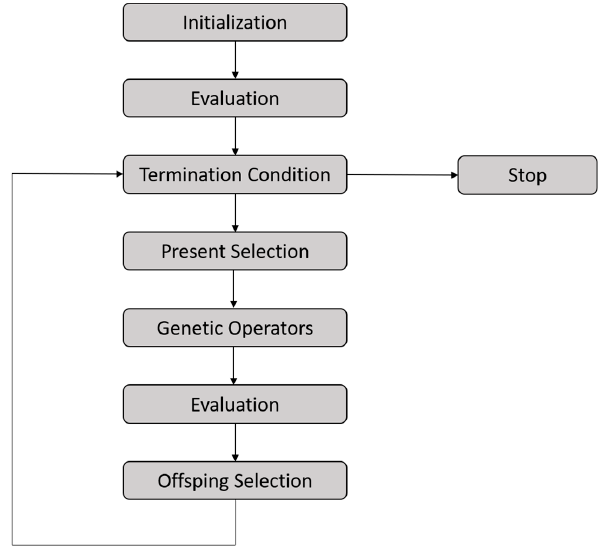
Figure 5. Steps for genetic algorithm—GAWizard (SIEMENS,